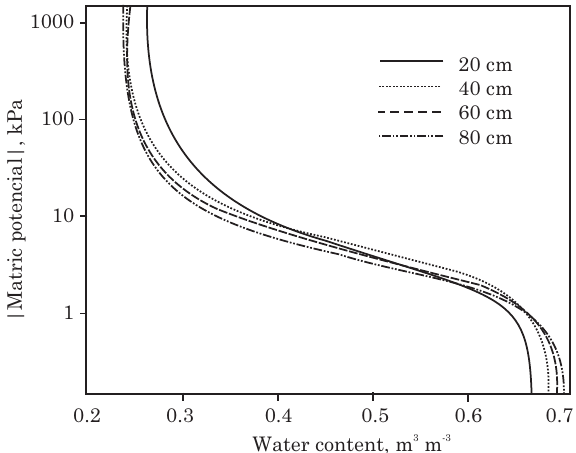
Figure 1. Soil water retention curves adjusted by the van Genuchten (1980) model for a Red Latossol at depths of 20, 40, 60, and 80